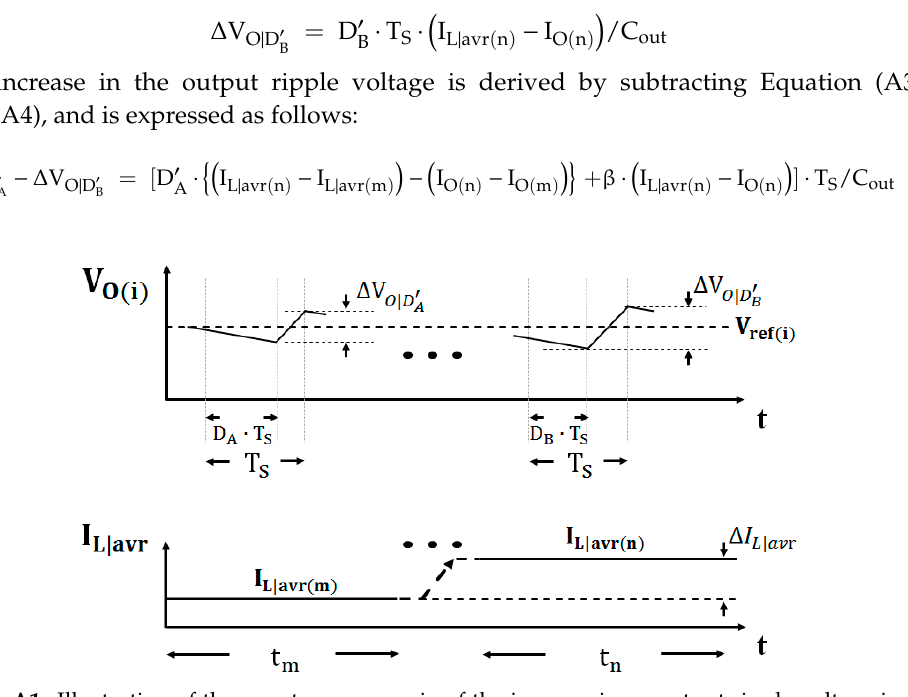
Figure A1. Illustration of the worst-case scenario of the increase in an output ripple voltage in the proposed EDRC scheme, where the average inductor current level is increased, and the operation mode is changed from IPSM A to IPSM B .